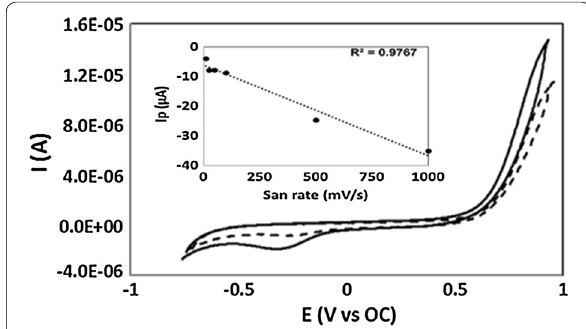
Fig. 3 Reduction peak confirmed to be associated with C. phytofermentans . With bacterial cells (solid line) in the medium, a reduction peak is observed. When the bacterial cells are removed (dashed line), the reduction peak is no longer observed. Inset: Linear regression of peak current versus scan rates. The peak current of each scan rate was plotted and corresponded surface associated electron transfer based on linear regression